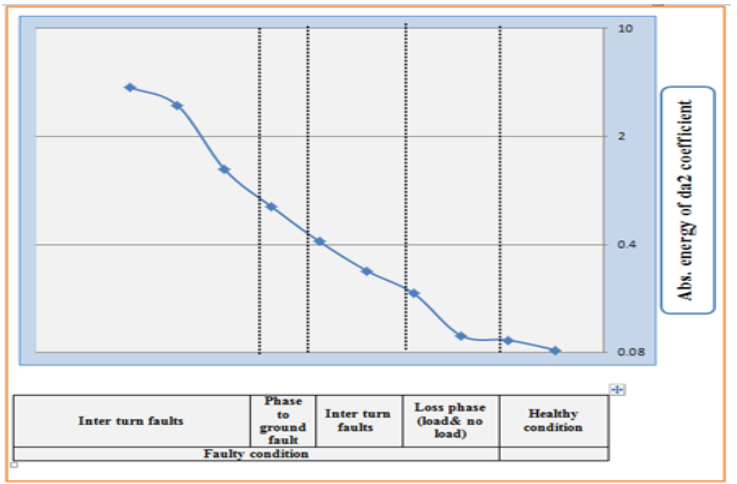
Figure 26. Entropy power energy value of WPT subband da2’s coefficients for different motor fault conditions, using captured experimental data.